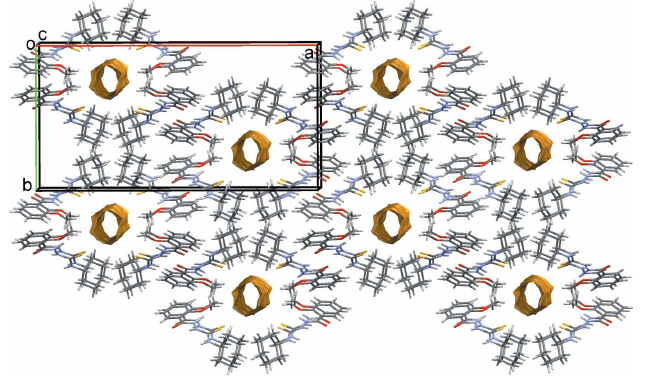
Figure 4 A view along the c axis of the crystal packing of the title compound, showing the region occupied by the disordered solvent ( Mercury ; Macrae et al. ,